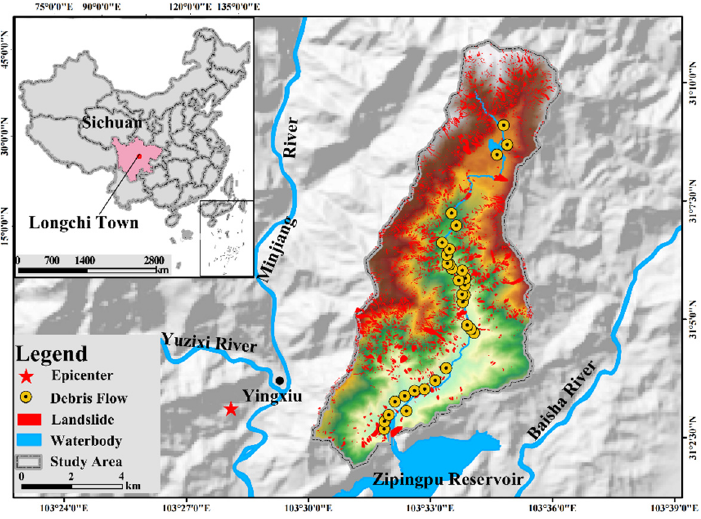
Figure 2. Location of Longchi town.